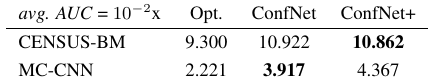
Table 2. Comparison of ConfNet (Tosi et al., 2018) and our mod- ified variant ConfNet+ on the KITTI-15 dataset (Menze and Gei- ger, 2015). All entries represent the average AUC x 10 − 2 over all images evaluated. The theoretically optimal value (Opt.) is shown in the second column. Values closer to the optimal AUC corresponds to higher accuracy. The best results for each of the two different stereo matching methods are highlighted.